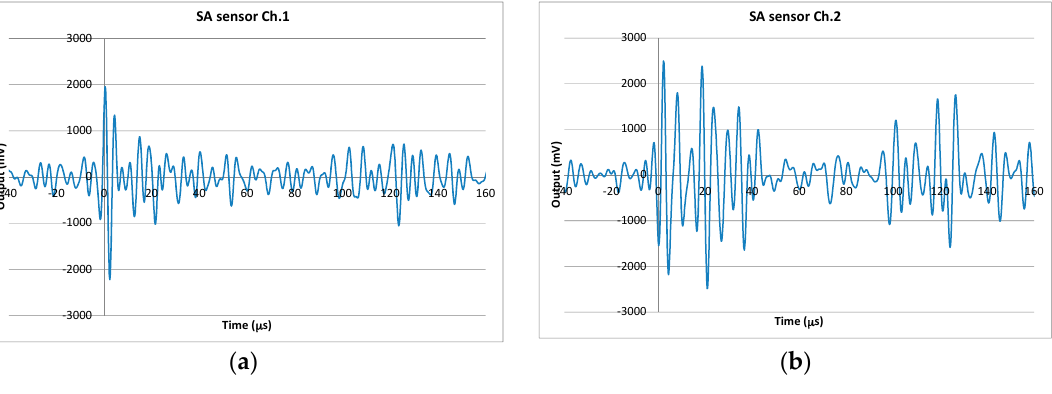
Figure 8. Waveform of SA sensor ( a ) ch.1 and ( b ) ch.2.